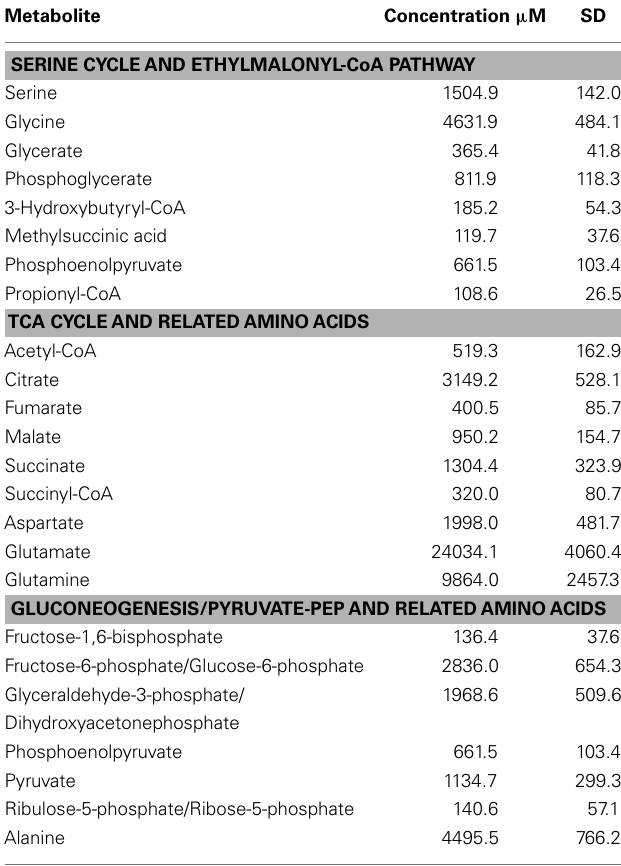
Table 2 | Intracellular pool of key metabolites in M. trichosporium